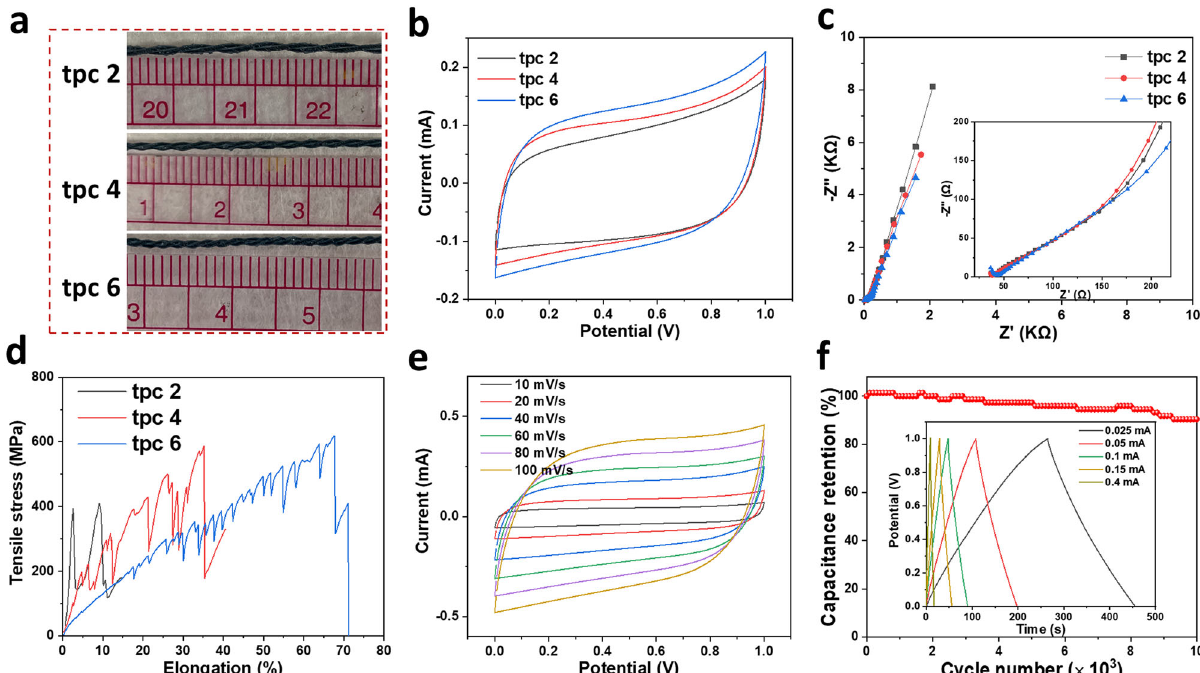
Fig. 2 Electrochemical and mechanical performances of TYCs at different plying levels. a Photos of TYCs with different ply-twist degrees, including tpc 2, tpc 4, and tpc 6; b , c CV curves (40 mV s − 1 ) ( b ) and Nyquist plots ( c ) of TYCs (50 cm) with different ply-twist degrees; d Typical stress-strain curves of TYCs with different ply-twist degrees; e , f CV curves at different scan rates ( e ) and capacitance retention upon 10,000 charge-discharge cycles, with the inset fi gure showing the GCD curves at different current densities ( f ) of a 50-cm-long TYC with tpc